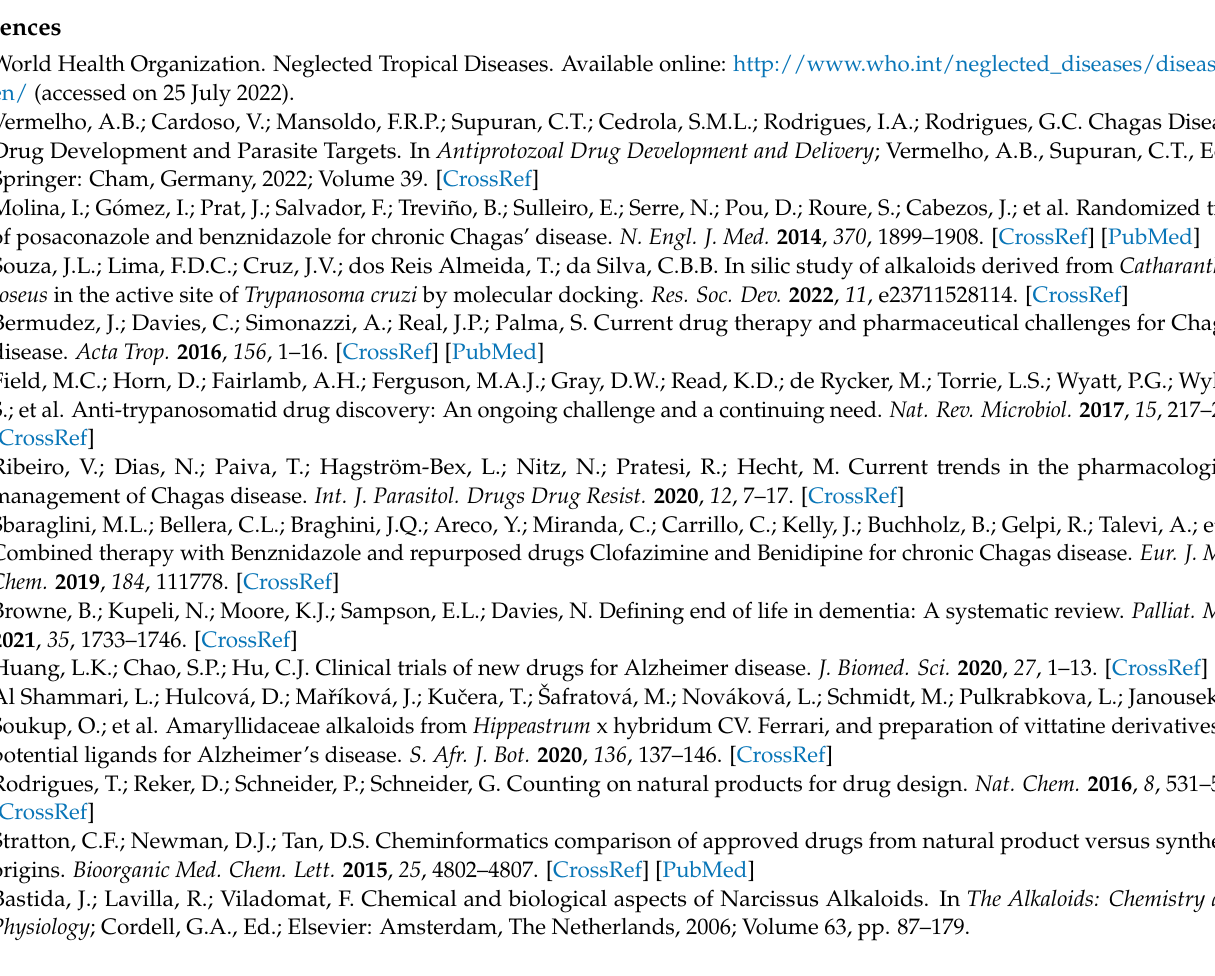
Figure S3: Alkaloids identified in Hippeastrum BAREs; Figure S4: The dose-effect curves of single drugs (A) and drug combos (B); Figure S5. Chou-Talalay method Fa-CI plot of montanine, H. hybrid BARE, and Bzn. Table S1: CI, DRI and Fa values of combinations of montanine, H. hybrid BARE and